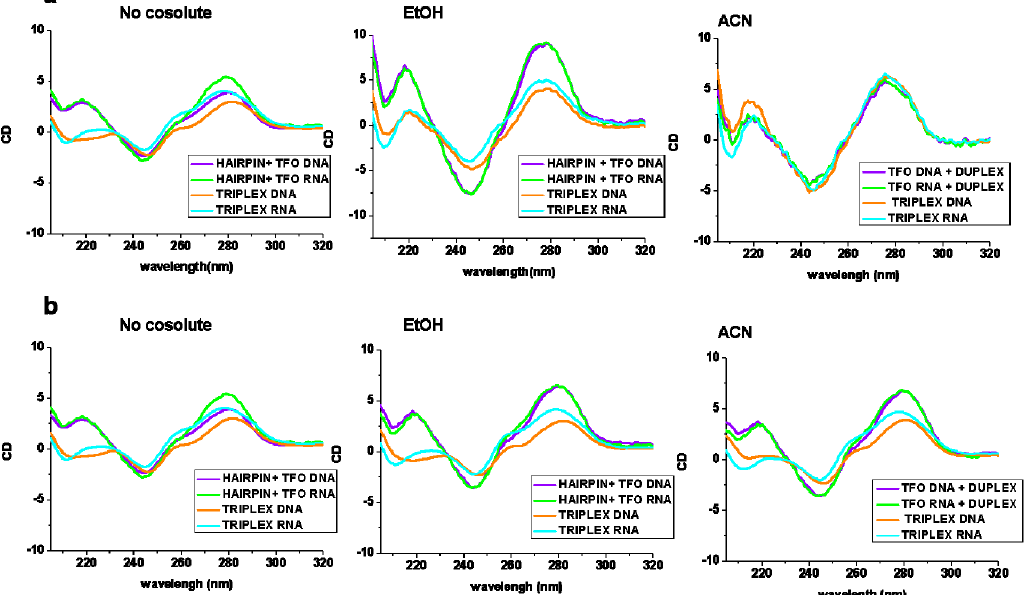
Figure 2. Comparison of CD spectra of the arithmetic sum of CD spectra of hairpin and TFOs (Hairpin + TFO-DNA (violet) and Hairpin + TFO-RNA (green)) and the CD spectra of the triplex structures (Triplex DNA (orange) and triplex RNA (blue)). ( a ) sequence 1 and ( b ) sequence 2. Buffer 10 mM phosphate buffer, 100 mM NaCl, pH 6.